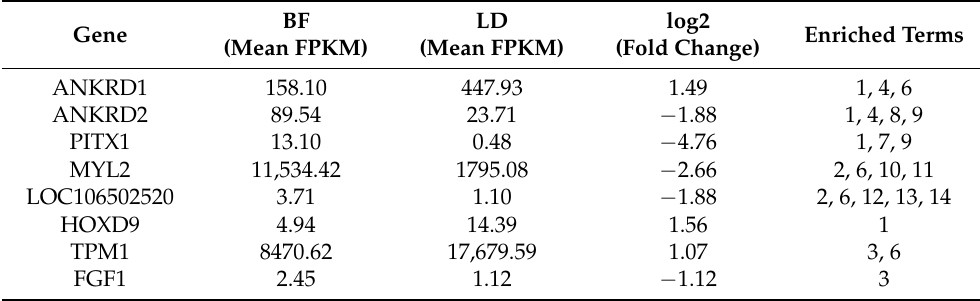
Figure 3. Gene Ontology (GO) enrichment of differentially expressed isoforms. Hyper-geometric distribution method is used. FDR ≤ 0.05 is considered as significantly enriched. Table 5. Differentially expressed genes identified from short-length sequencing that associated with muscle growth and tenderness by GO analysis.